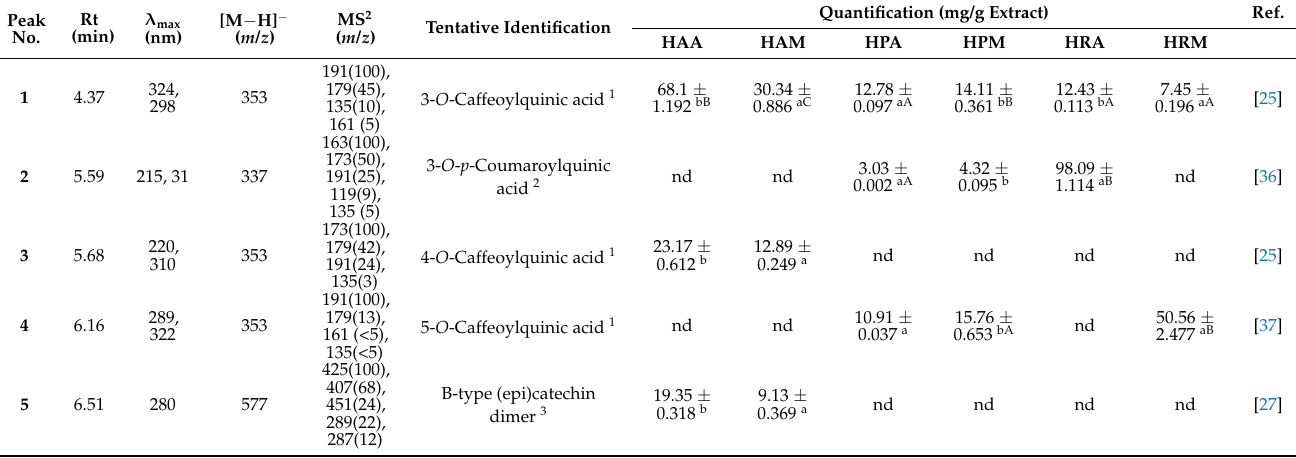
Table 1. Chromatographic features and quantitative distribution of phenolic compounds identified through LC-DAD-ESI/MS n in Hypericum